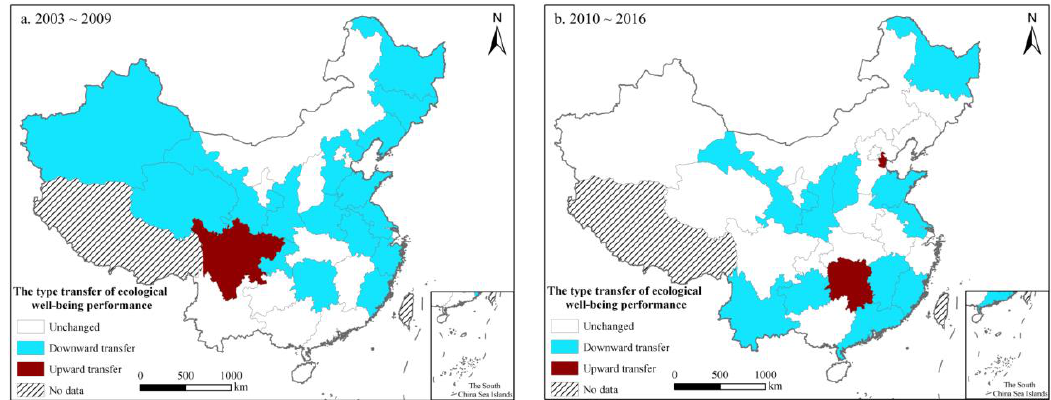
Figure 3. Spatial distribution of ecological well-being performance type transfer in China in different stages.